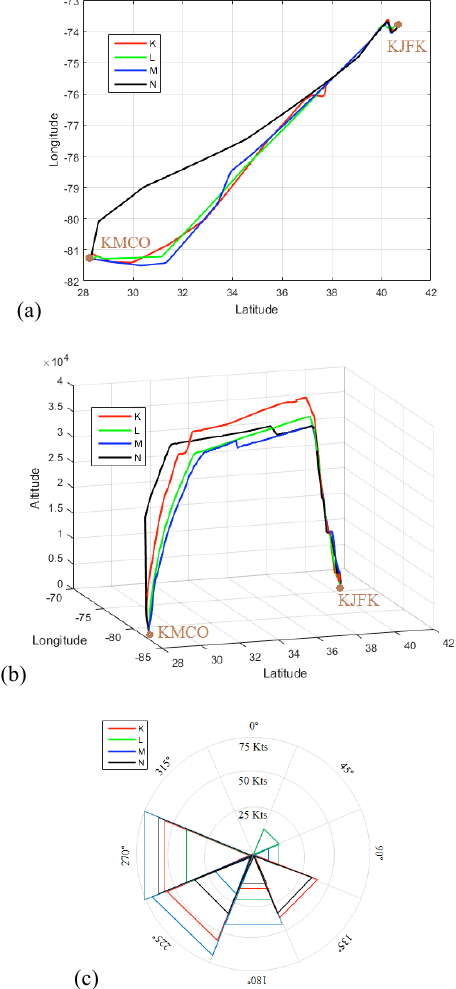
Figure 4. Representation of four trajectories between KMCO and KJFK airports: (a) Airplanes latitude and longitude; (b) Airplanes latitude, longitude, and altitude; (c) Wind (direction and magnitude) rose diagram.